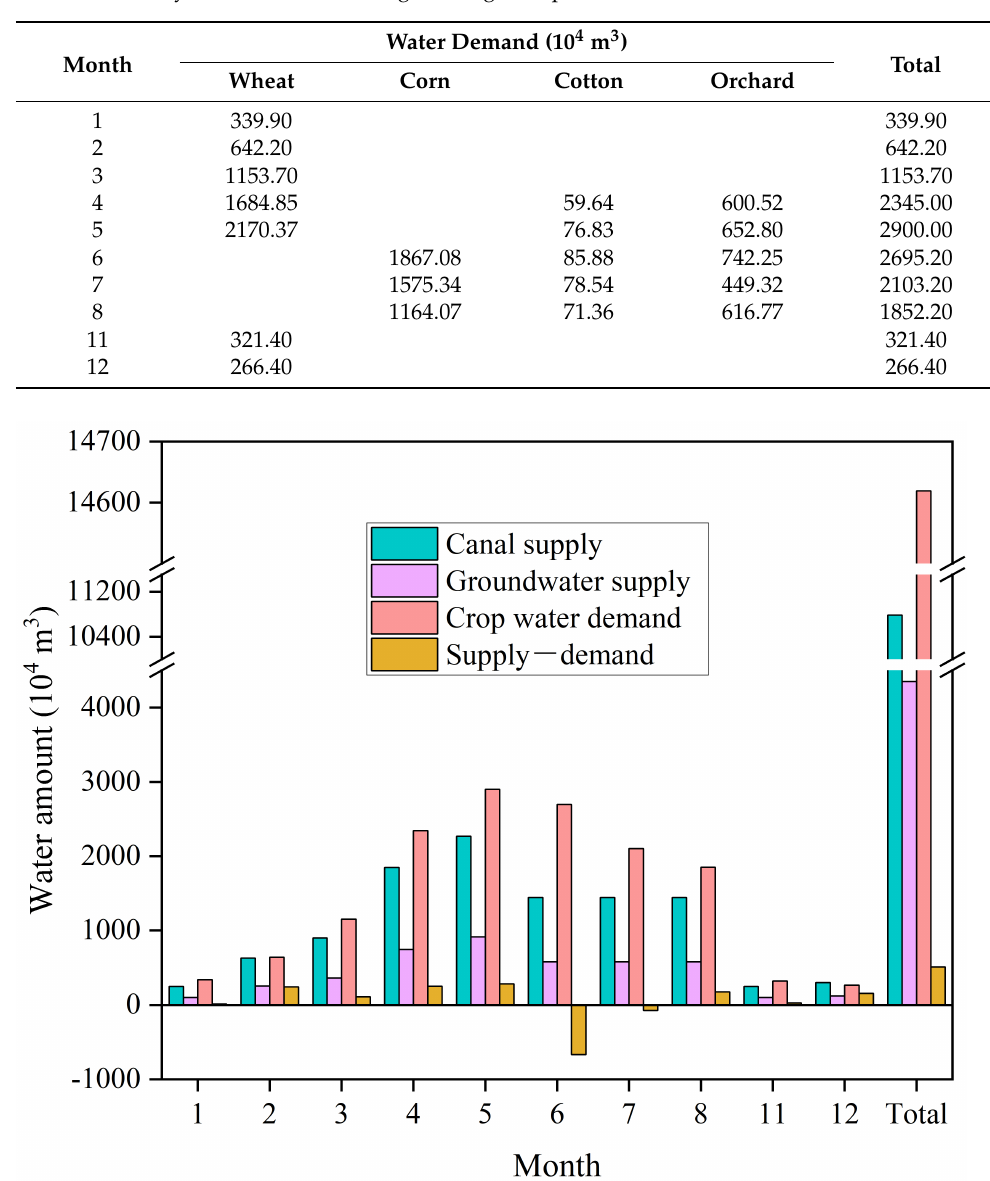
Figure 6. The relationship between crop water demand and